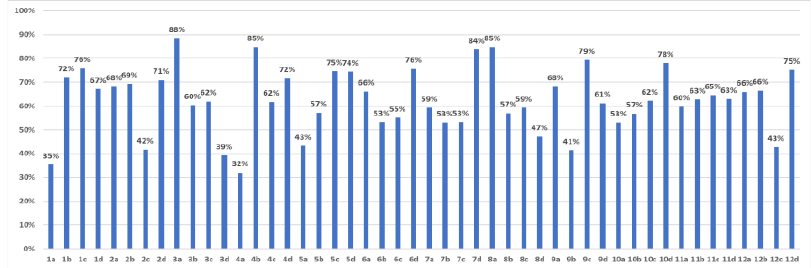
Fig. 3. Scores distribution to the KLSI questions.